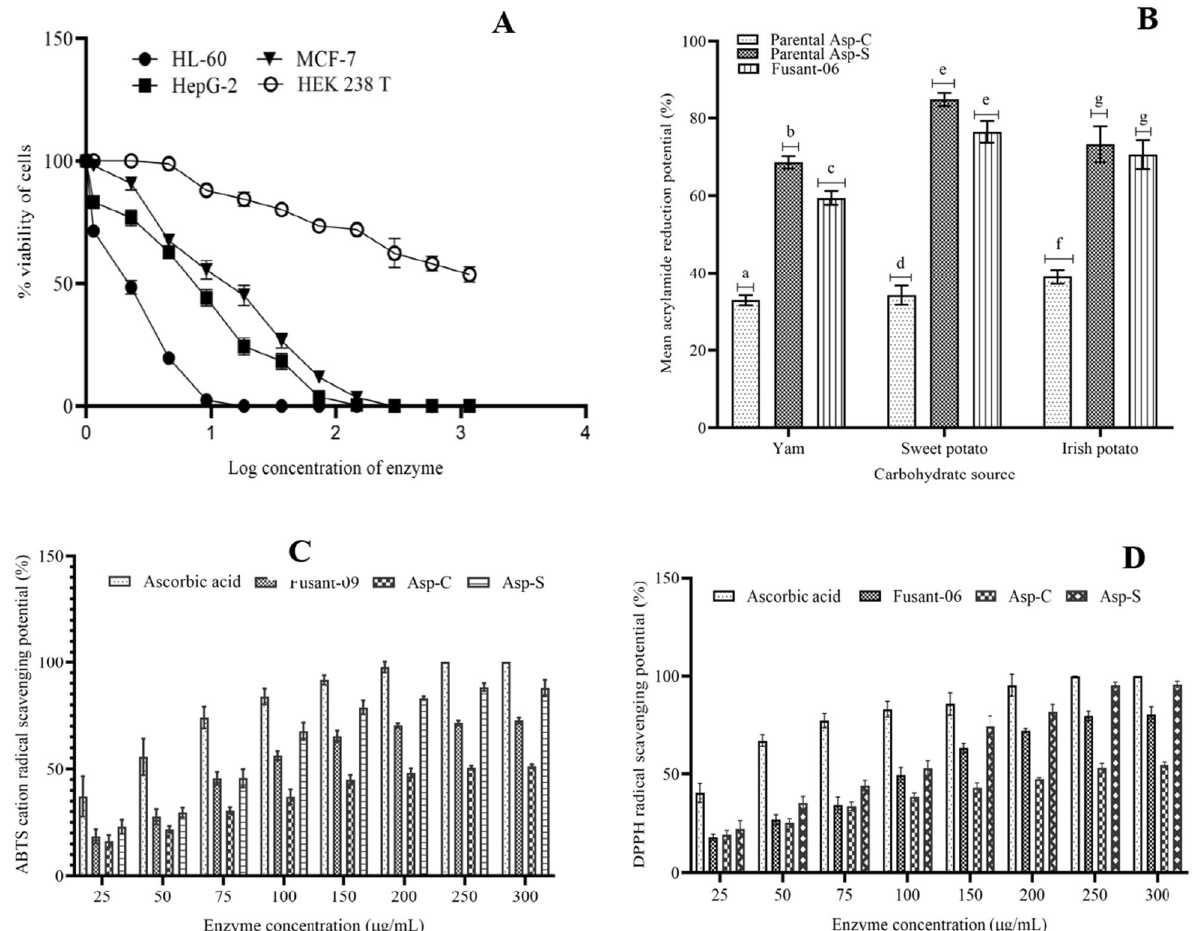
Fig. 4 Cytotoxic potential ( A ), acrylamide reduction potential ( B ), concentration-dependent ABTS ( C ) and DPPH ( D ) free-radical scavenging potential of l -ASNases; values are means of triplicate determinations and error bars are standard deviations. Bars with similar alphabets are not statistically different from each other while those with dissimilar letters are statistically different from each other at significance level of